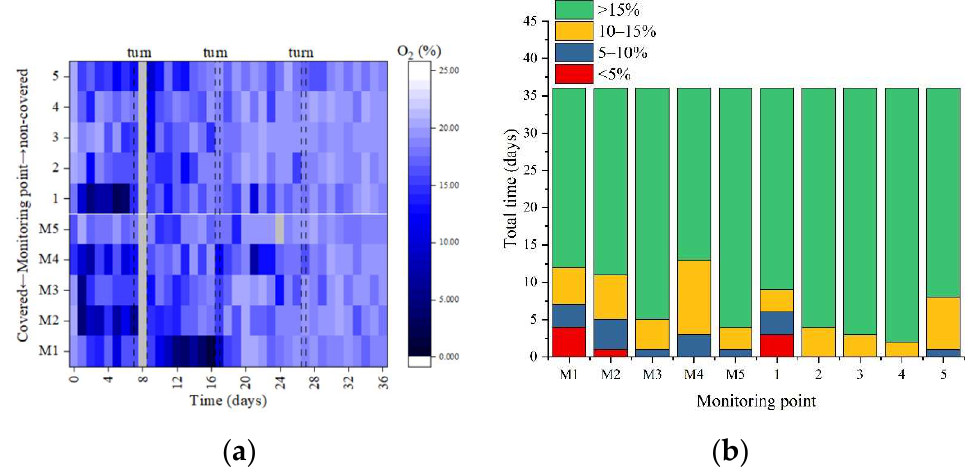
Figure 4. Spatial distribution of oxygen concentration ( a ) and proportion of total time in different oxygen concentration ranges ( b ) at different monitoring points during the aerobic composting. M1–5, the five monitoring points in the covered group.